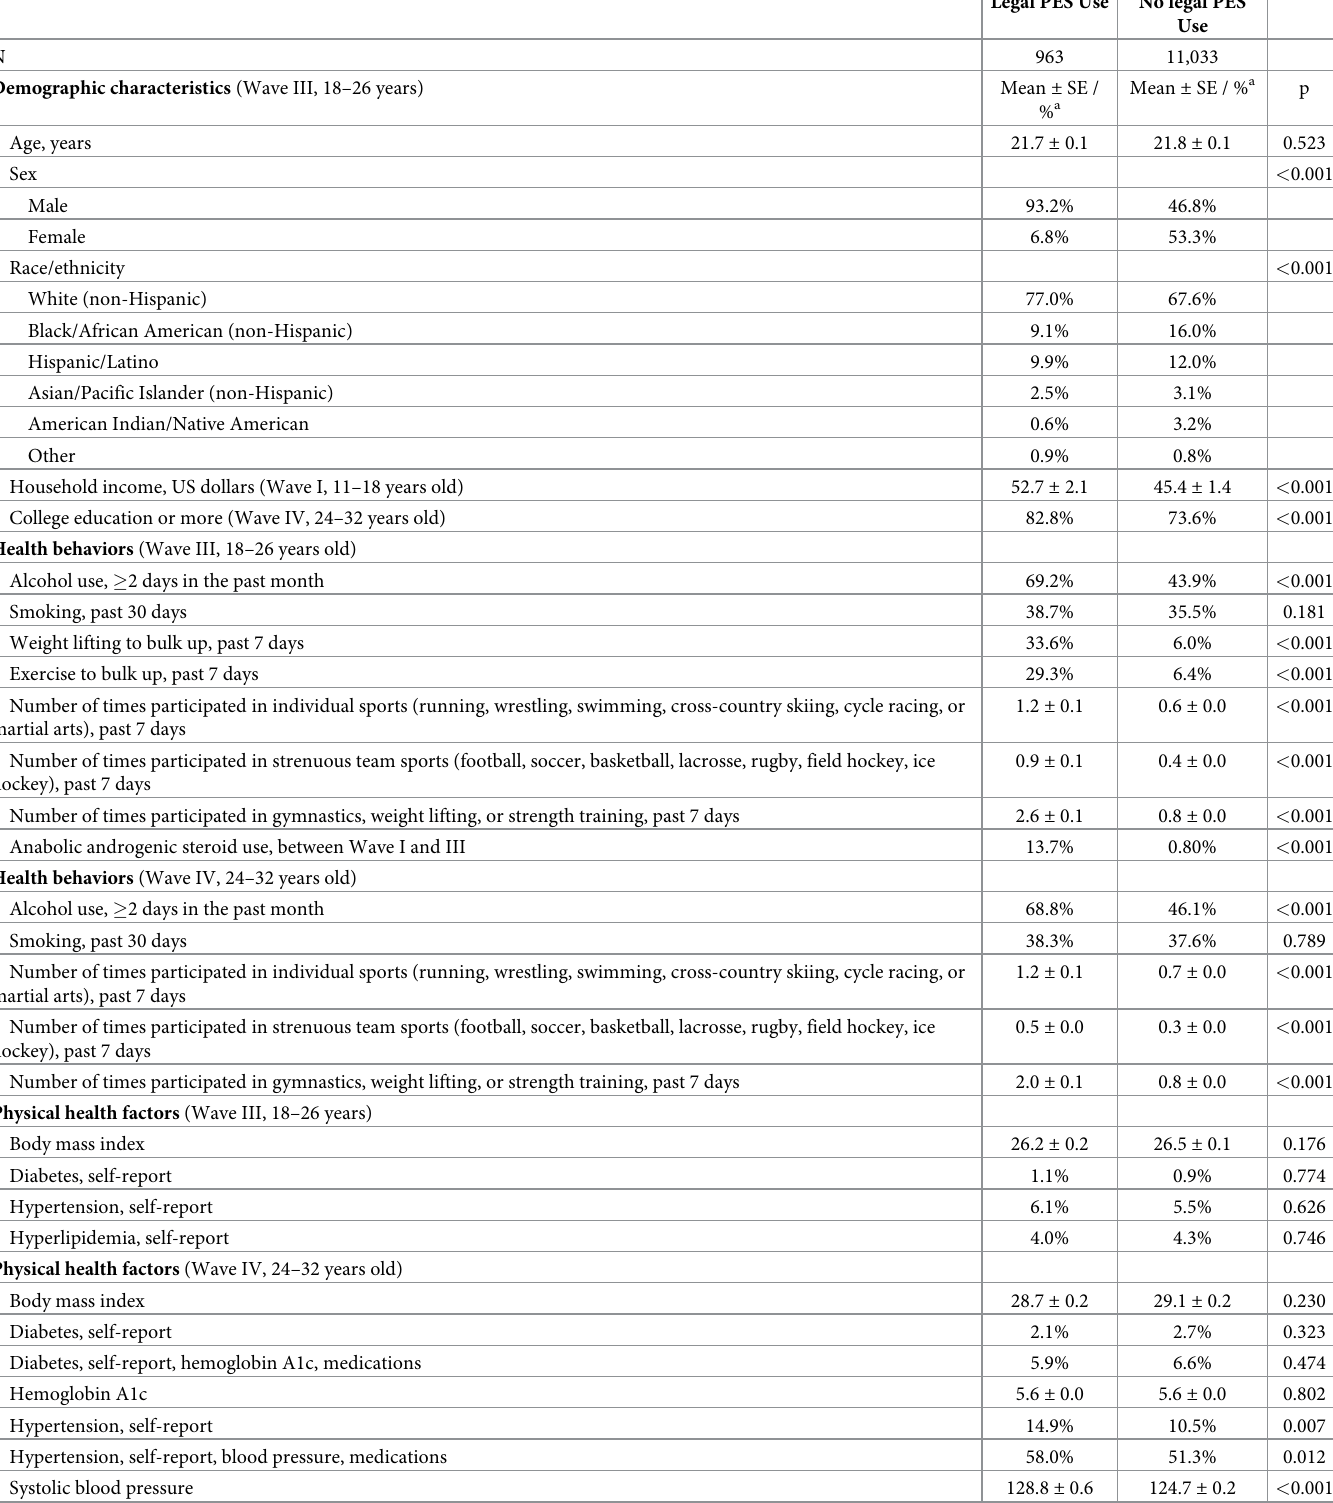
Table 1. Descriptive and health characteristics of 11,996 young adult participants in the National Longitudinal Study of adolescent